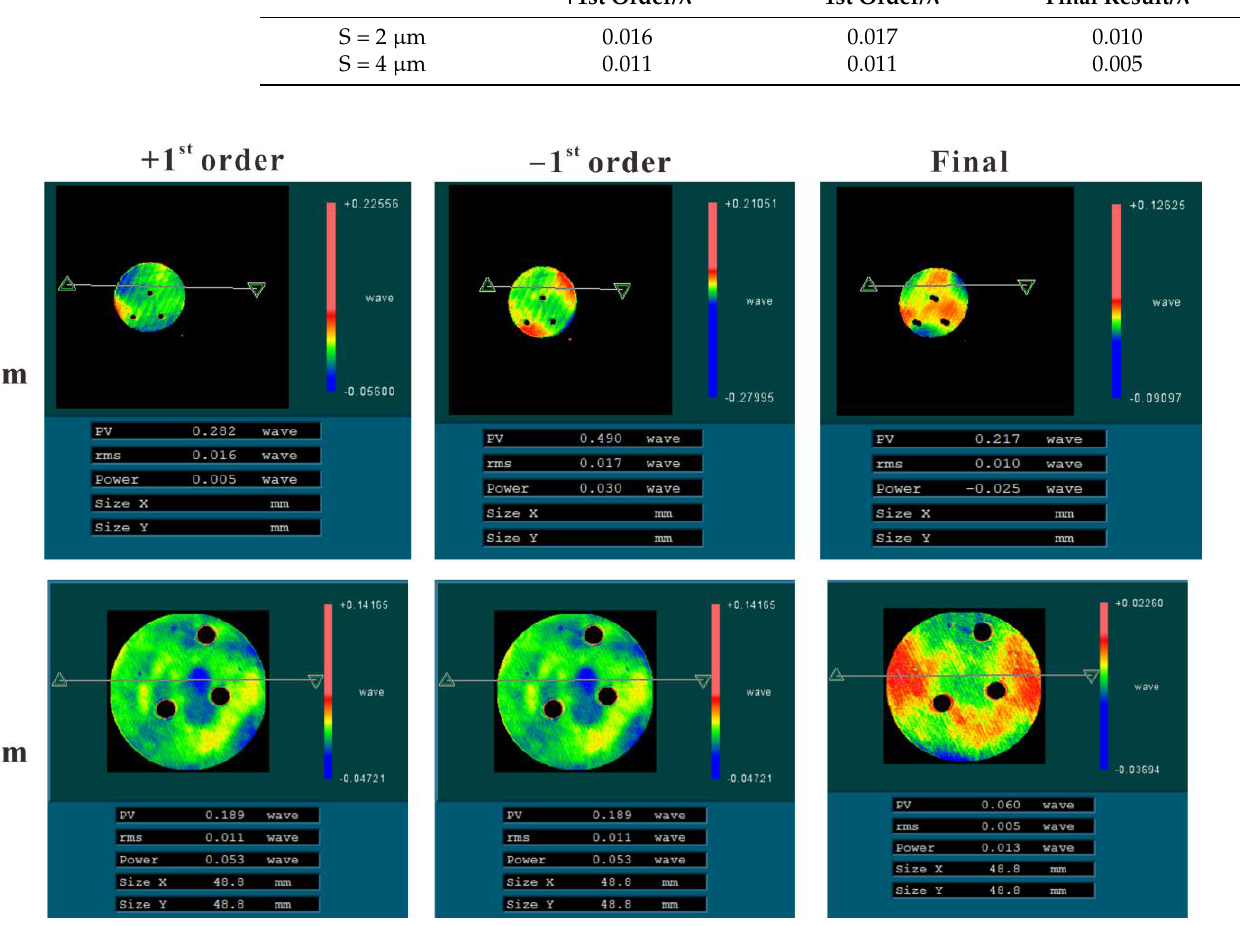
Figure 11. Wavefront aberration of ±1 diffraction orders and final data for S = 2 and 4 μm grating elements caused by fabrication errors . Table 2. The RMS values of test results in Figure 11.